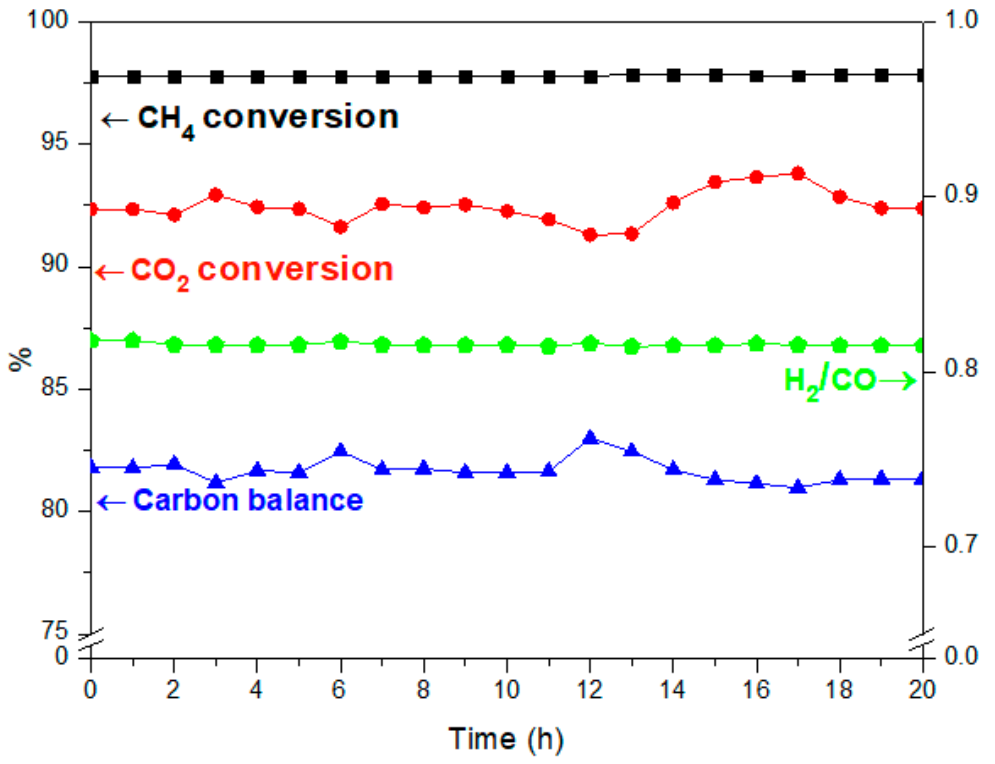
Figure 3. Stability test of Co 2 Ni 2 Al 2 Mg 2 800 in DRM at 800 °C for 20 h.